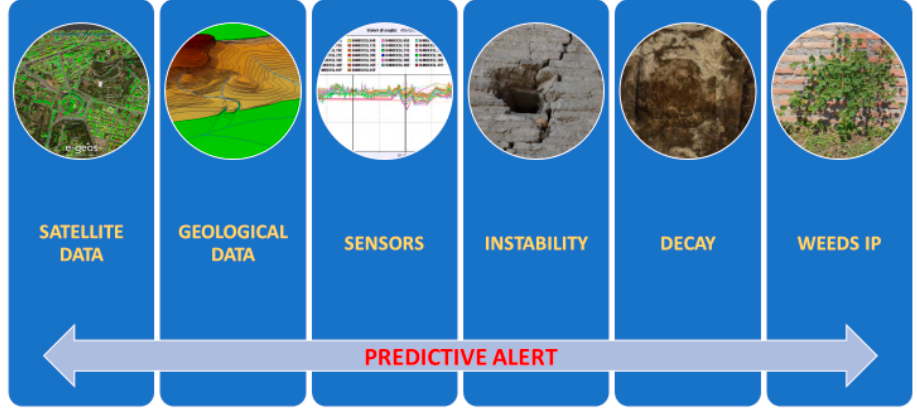
Figure 12. Schematic representation of the interrelationships involved in generating the SyPEAH predictive alert.